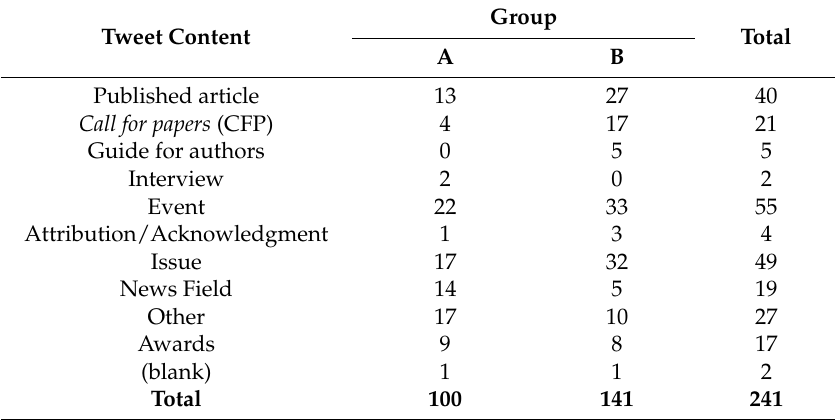
Table 3. Tweet type of content in both categories of RT (A/B) *.